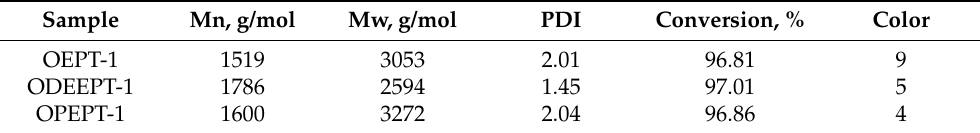
Figure 8. GPC curves of OEPT-1, ODEEPT-1, and OPEPT-1 samples.